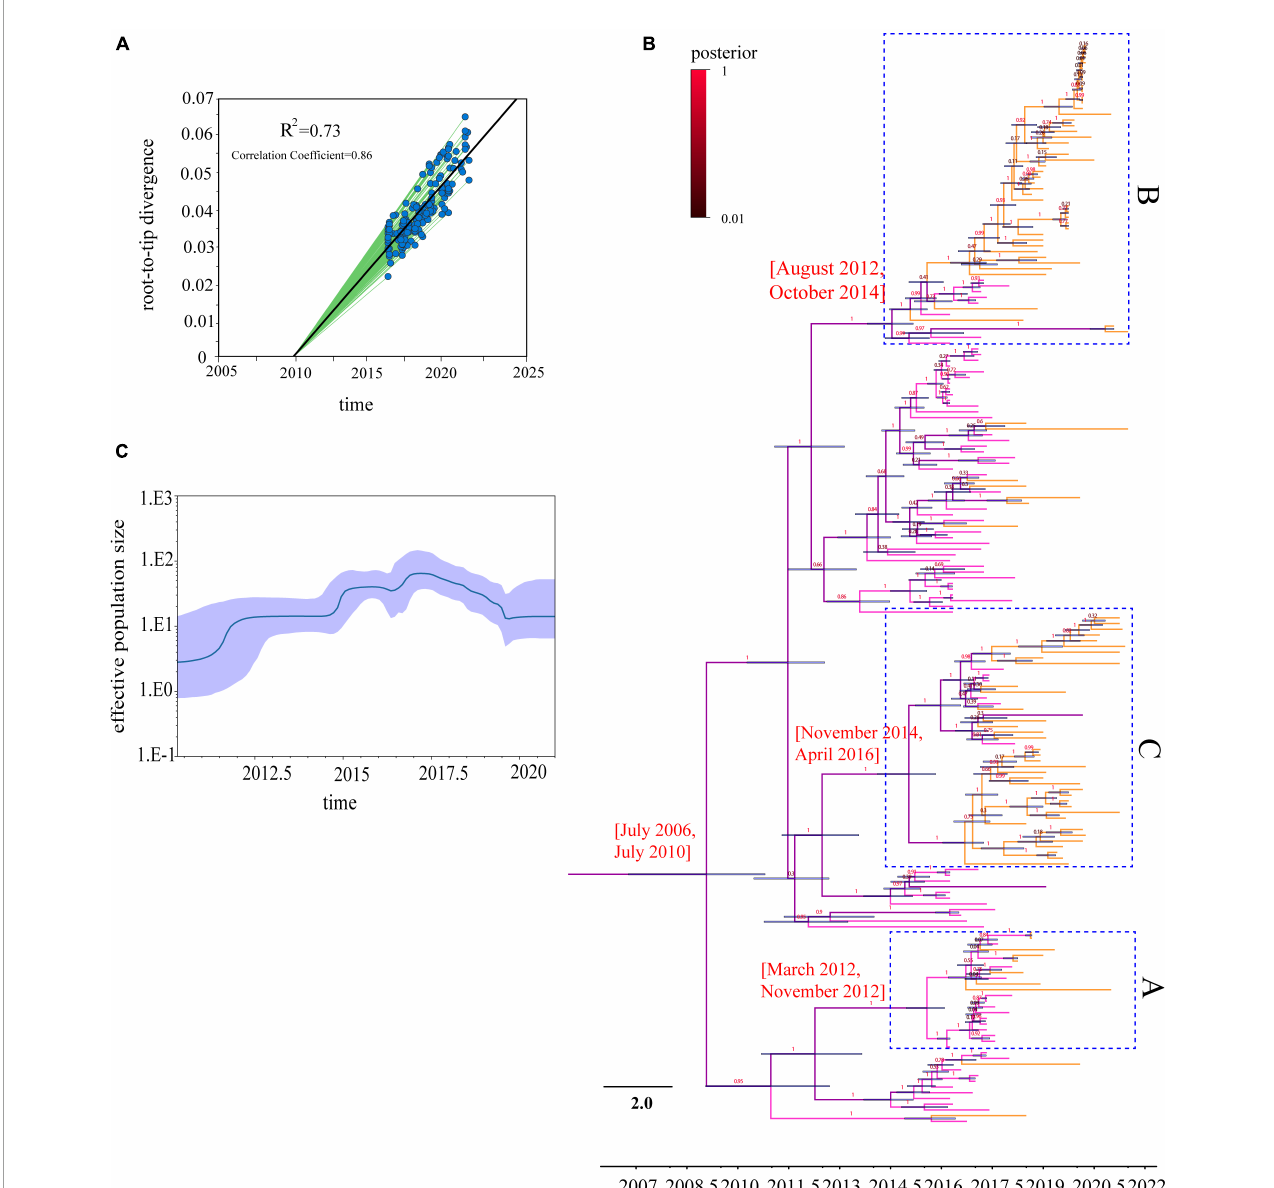
FIGURE3 Time-scaled evolution of HA gene of H9N2 viruses in 2016–2021: (A) Analysis of root-to-tip divergence against sampling date for HA gene segment, R 2 = 0.73; (B) an MCC tree of the HA sequence of H9N2 viruses sampled in China ( n = 189) in 2016–2021 is shown. H9N2 viruses from different periods are denoted by different colors (pink represents the 2016–2017 H9N2 strains, orange the 2018–2021 strains, and the posterior probabilities of each branch are shown on a scale, with red representing the maximum posterior probability). Shaded bars represent the 95% highest probability distribution for the age of each node; (C) a GMRF Bayesian skyline analysis of the HA gene of H9N2 viruses in China in 2016–2021 to display changes in the effective population size over time. The solid red line indicates the median value, and the shaded blue area represents the 95% highest posterior density of genetic diversity estimates.